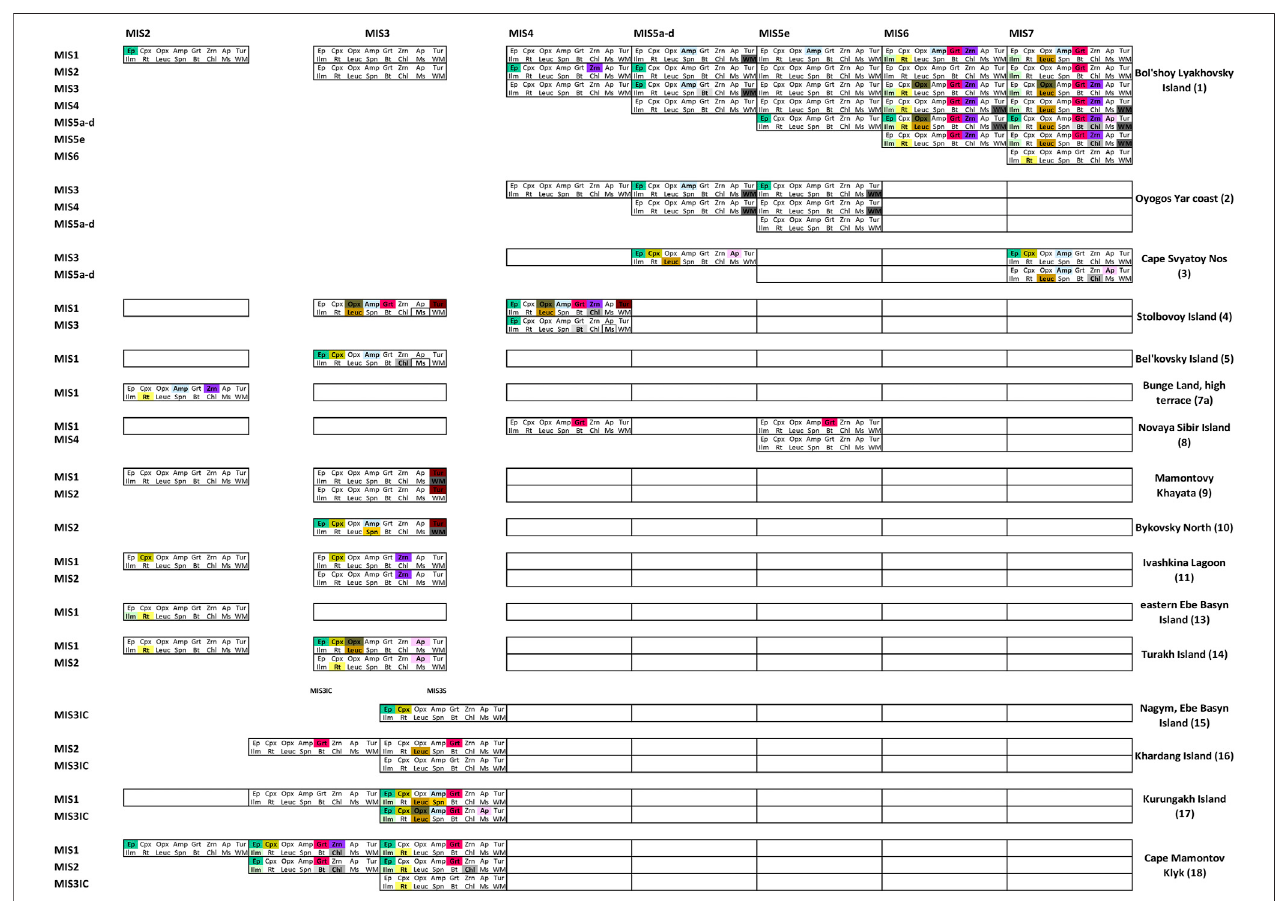
FIGURE7| Comparisonofstratigraphic-wisemeanvaluesofmineralassociationsofthe fi nefractionfromsites(sitenumbersaccordingto Figure2 )withsuf fi cient number of samples. using the Tukey Honest Signi fi cant Differences Test (Tukey, 1949). The background coloring shows minerals with signi fi cantly different means among the compared stratigraphic units. (Ep — epidote, Cpx — clinopyroxene, Opx — orthopyroxene, Amp — amphibole, Grt — garnet, Zrn — zircon, Ap — apatite, Tur — tourmaline, Ilm — ilmenite, Rt — rutile, Leuc — leucoxene, Spn — sphene, Bt — biotite, Chl — chlorite, Ms — muscovite, WM — weathered mica).